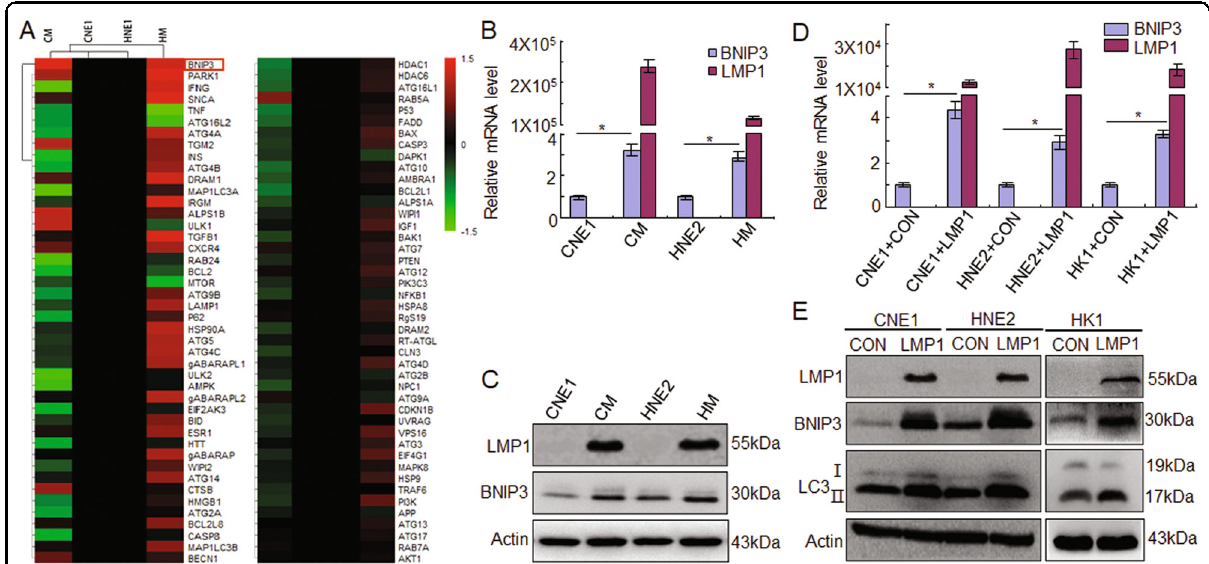
Fig. 2 LMP1 increases BNIP3 expression in NPC cells. A A PCR array was used to detect changes in the expression of autophagy-related genes in LMP1-positive NPC cells compared with LMP1-negative NPC cells. B Quantitative RT-PCR and C Western blots were performed to analyze LMP1 and BNIP3 expression in NPC cells. D Quantitative RT-PCR and E Western blots were performed to analyze LMP1, BNIP3, and LC3 expression after transfection with LMP1 in NPC cells. CON: negative control, Data are expressed as means ± S.D. of three experiments. * p <